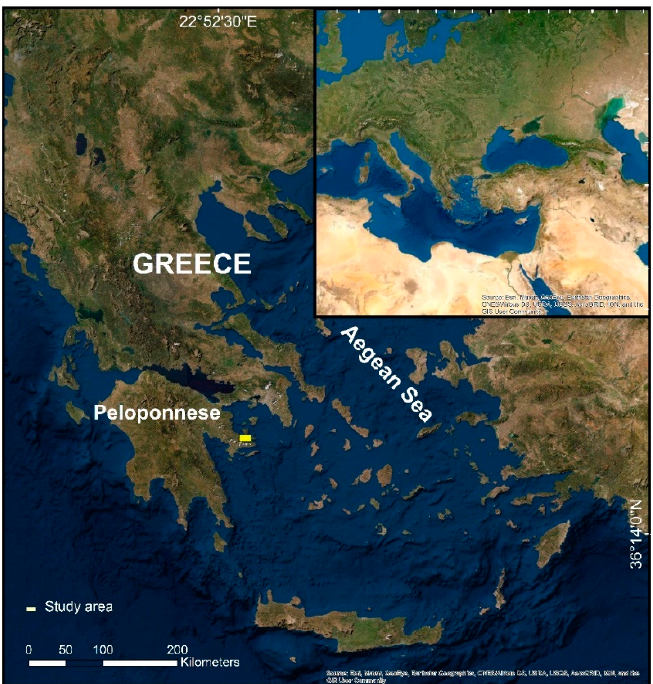
Figure 1. Map showing the location of the area studied (modified from [31]).